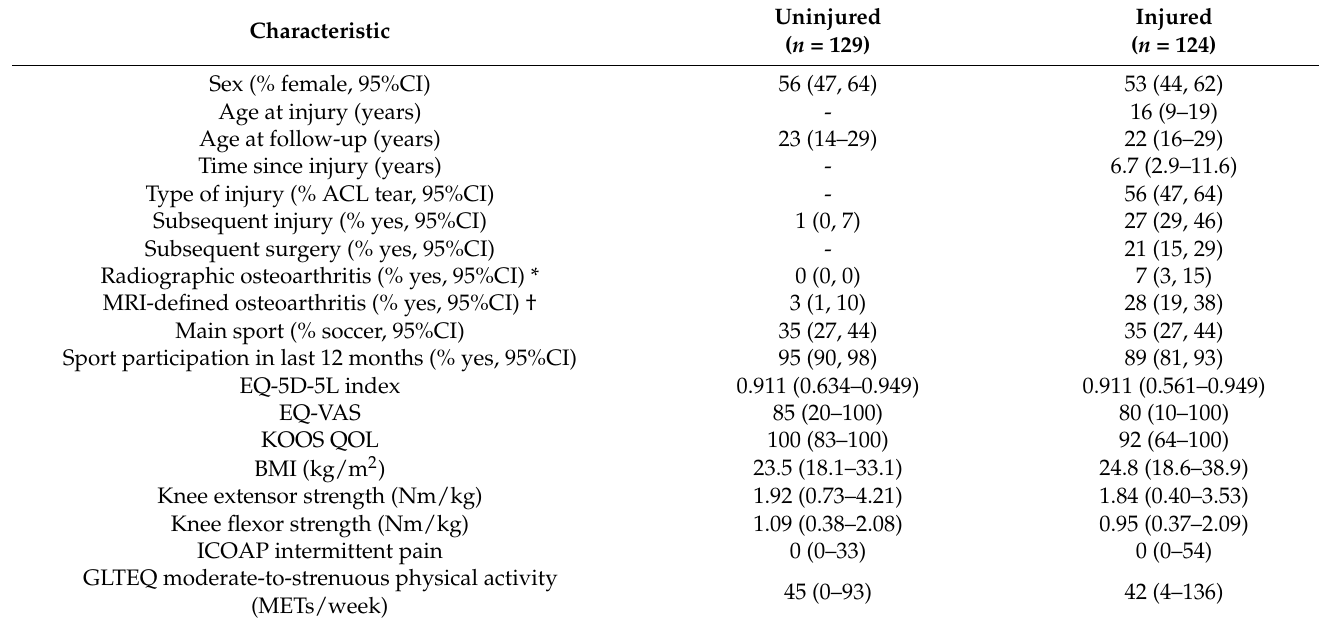
Table 1. Participant characteristics, outcomes, and covariates by study group.